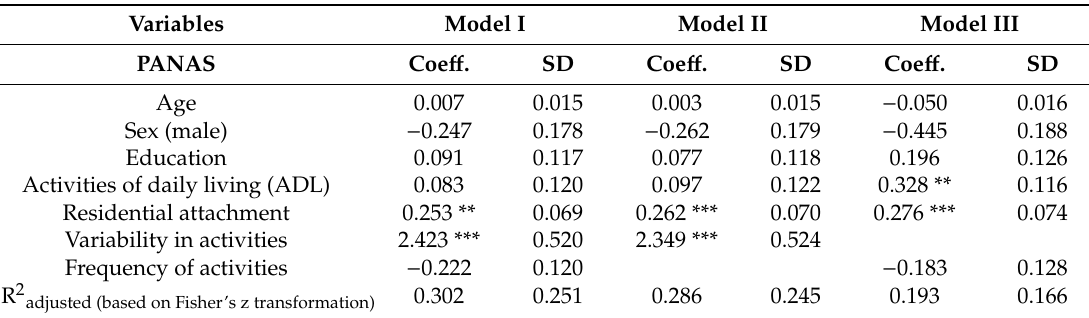
Table 4. Regression